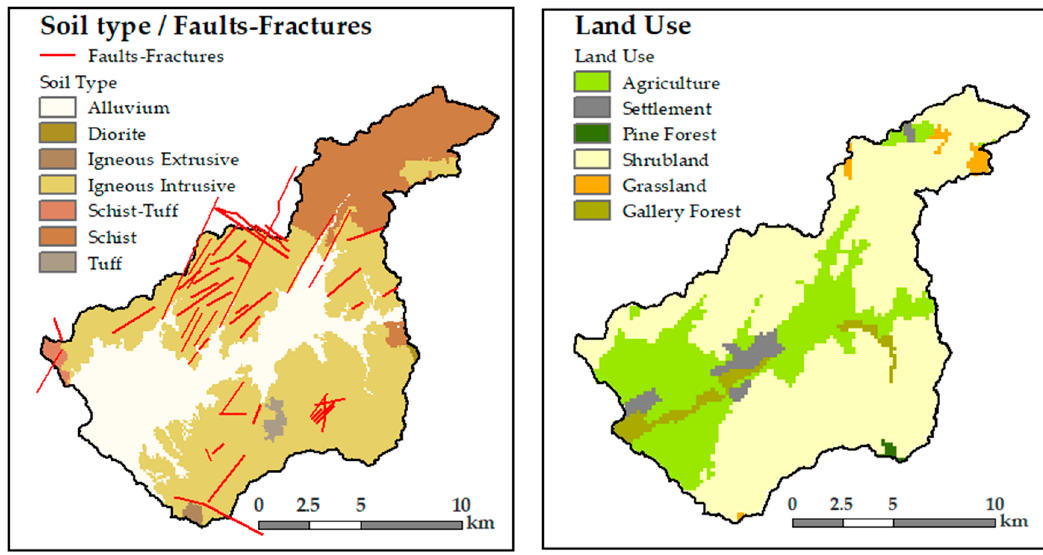
Figure 6. Lithological and land use maps of the study area.